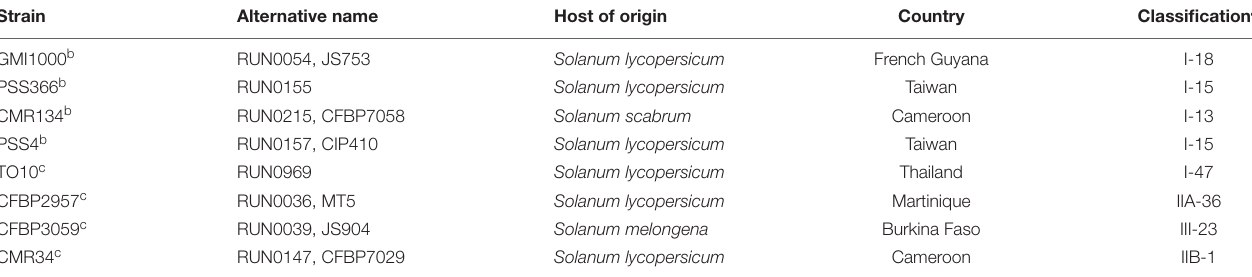
TABLE 1 | Description of the eight R. solanacearum species complex strains used for phenotyping the eggplant [MM738 × AG91-25] RIL population.